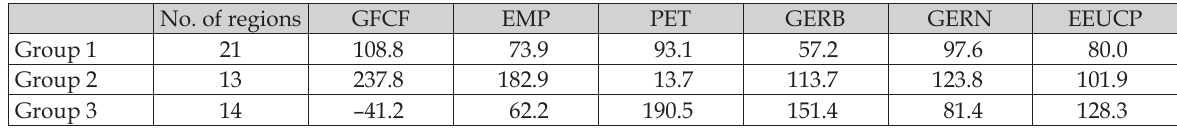
Table 5. Mean values of clustered groups in relation to the CEE average (in %; CEE = 100).